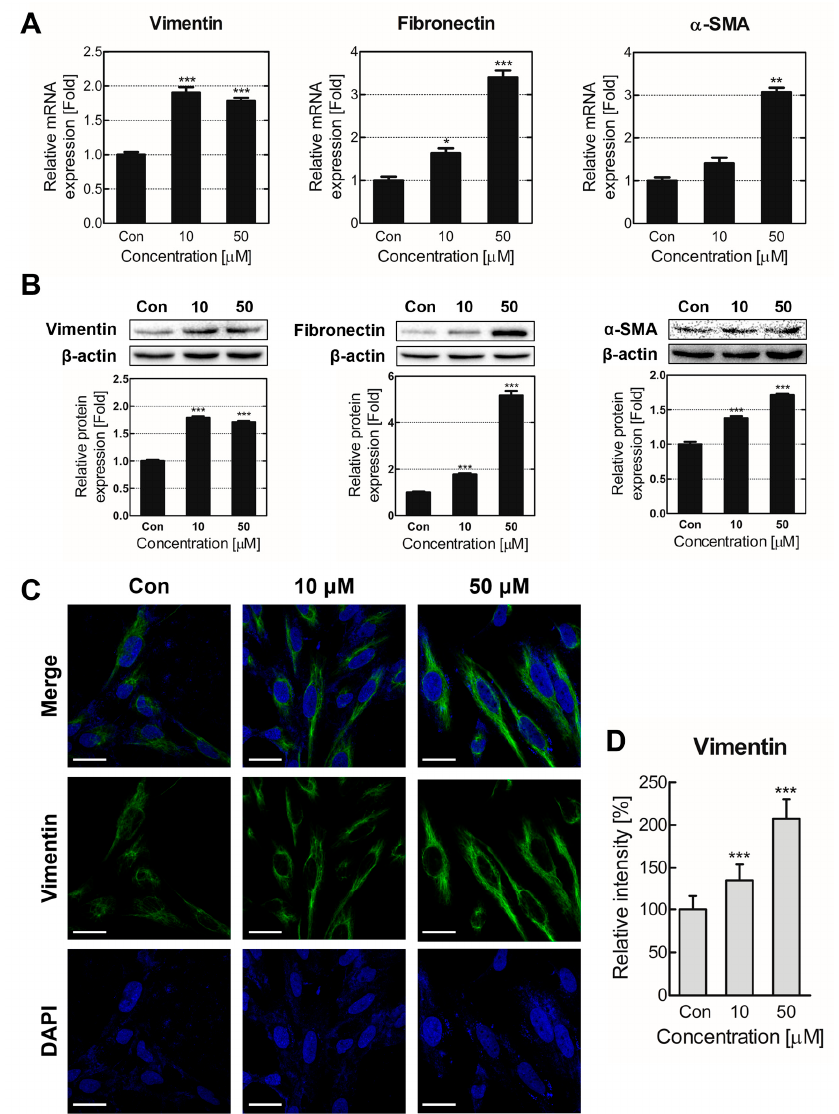
Figure 2. Epithelial-mesenchymal transition (EMT) gene expression increased from chronic TDI exposure. EMT marker (vimentin, fibronectin, and a-SMA) expression levels were confirmed through the chronically TDI-exposed model. ( A ) Vimentin, fibronectin, and α -SMA gene expression levels were analyzed through qRT-PCR. ( B ) Vimentin, fibronectin, and α -SMA protein expression levels were measured. ( C ) Alexa 488 and DAPI labeled the intracellular vimentin and nucleus, respec- tively. ( D ) Intracellular vimentin was quantified through Image J software. Every experiment was performed over three times. * p < 0.05; ** p < 0.01; *** p < 0.001 compared to the control group; Con: control; Scale bars: 20 μ m.